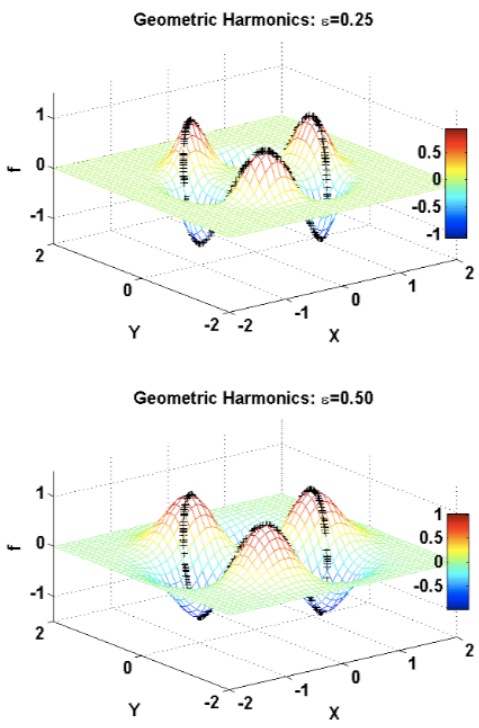
Figure 8. The function f = cos(3 ϑ ) , with ϑ = arctan( Y/X ) , is extended to the plane, ( X, Y ) , by Geometric Harmonics using ε = 0 . 25 ( top ) and ε = 0 . 5 ( bottom ). The 0 0 , ..., y } , is given by M = 350 points randomly selected on the unit circle sample set, { y 1 M (black